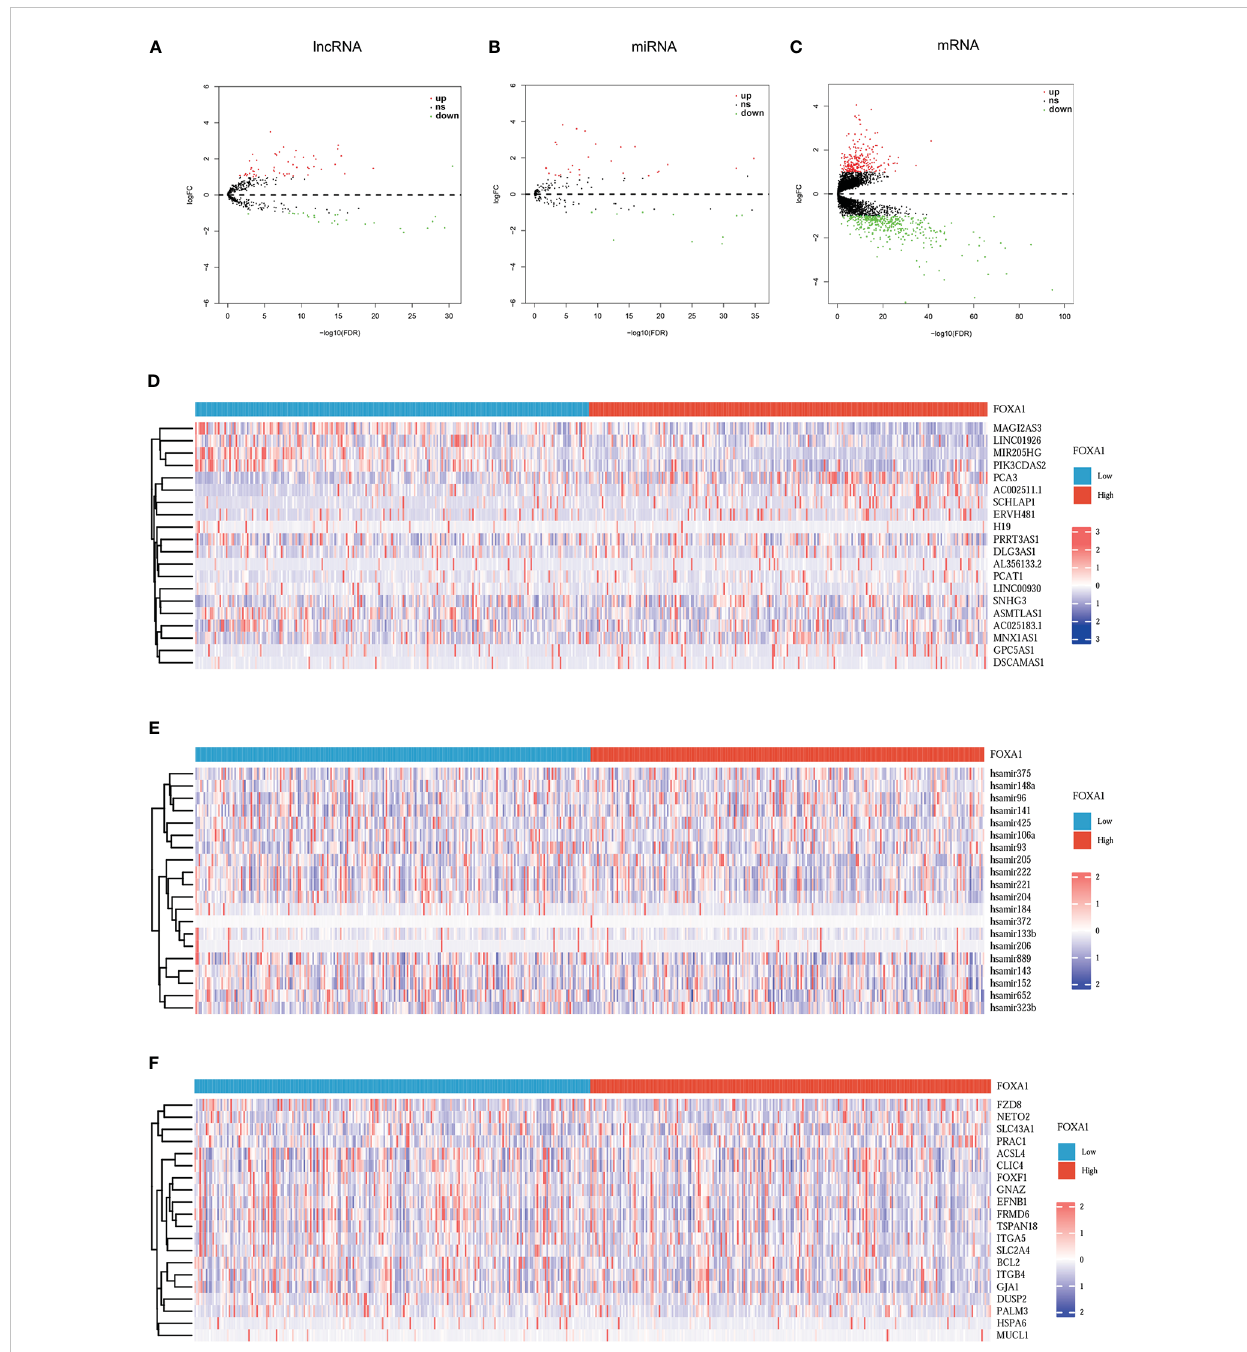
FIGURE 3 Volcano plots and heatmap plots of DElncRNAs, DEmiRNAs, and DEmRNAs between the expression of FOXA1 high and FOXA1 low in PCa samples. Red represents upregulated genes and blue indicates downregulated genes. (A – C) The volcano plots describe (A) 81 DElncRNAs (|log 2 fold change| > 0.5 and adjusted p -value < 0.05), (B) 38 DEmiRNAs (|log 2 fold change| > 0.3 and adjusted p -value < 0.05), and (C) 653 DEmRNAs (|log 2 fold change| > 0.5 and adjusted p value < 0.05). (D – F) The horizontal axis of the heatmap indicates the samples, and the vertical axis of the heatmap indicates 15 signi fi cant